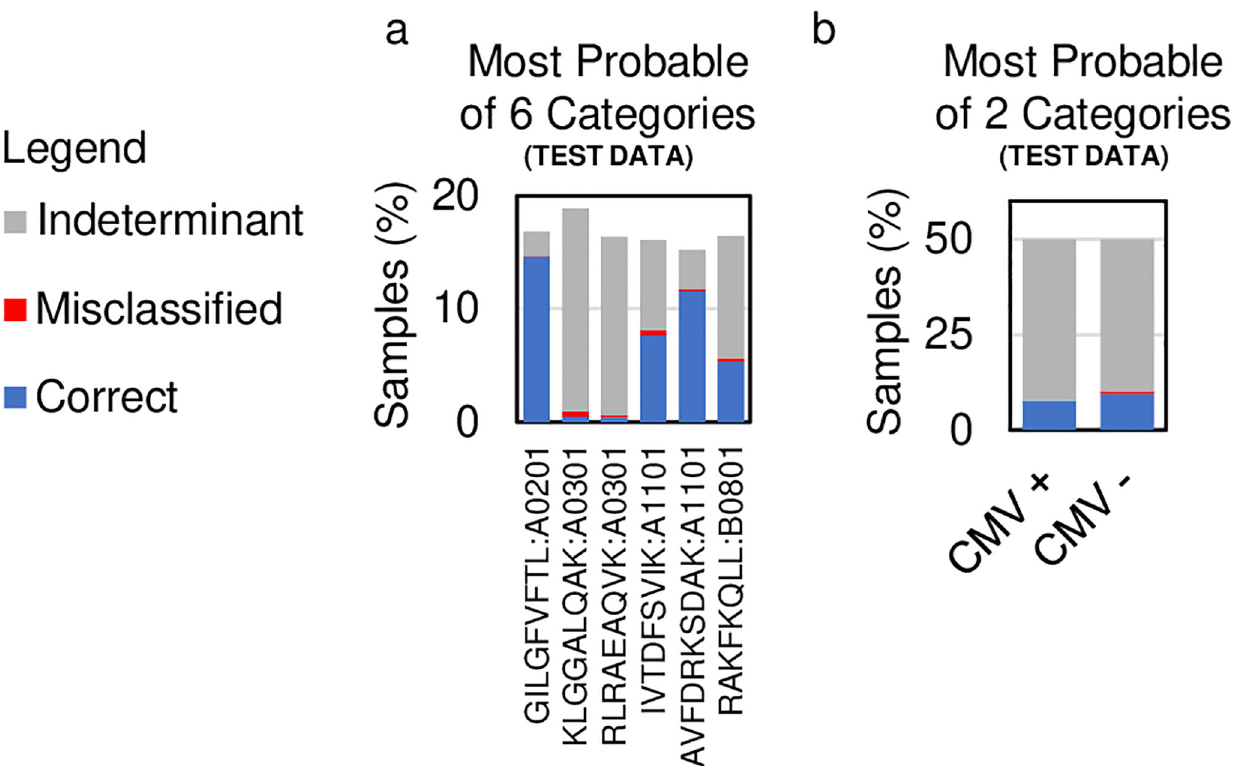
Fig 4. Results with confidence cutoffs. The bar charts show the fraction of samples that are correctly classified (blue), incorrectly classified (red), and indeterminate (grey) (a) Using a 95% confidence cutoff determined on the validation cohort, the classification accuracy on the test cohort of the antigen classification problem is 97.06% capturing 44.5% of samples. The samples are not captured evenly across the six categories. (b) Using a 95% confidence cutoff determined using the validation cohort, the classification accuracy on the test cohort of the repertoire classification problem is 96.0% capturing 18.0% of samples. The samples are captured almost evenly across the two